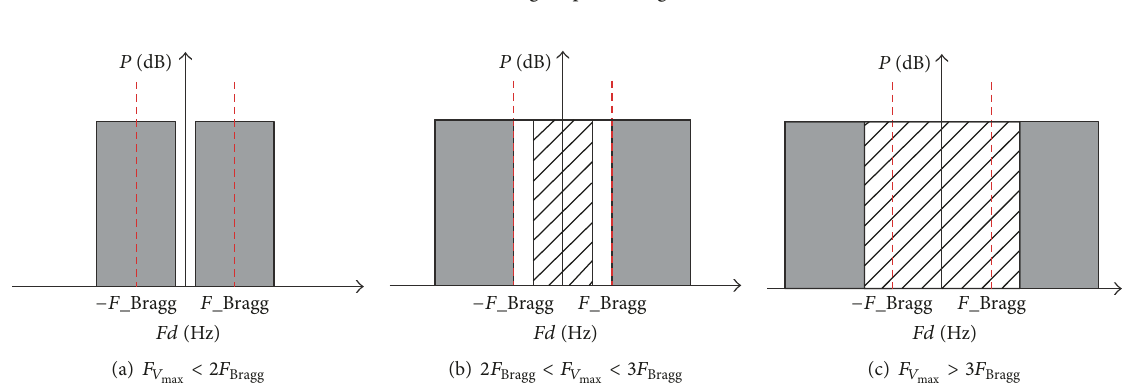
Figure 6: Signal processing flow.